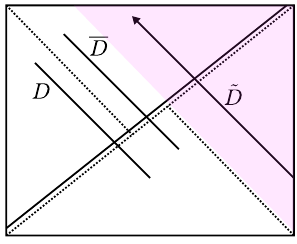
Figure 11 . The infalling observer as a gravitational shockwave. The interior mode D is outside a shaded region that may be in(cid:13)uenced by quantum operations on the right hand side. The original mode ~ D emerges from the right hand side, and is not longer entangled with D